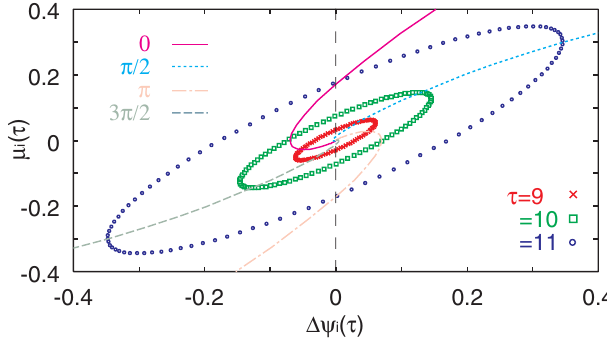
(cid:2) (cid:6) (cid:4) i (cid:2) 0 (cid:4) (solid line), i (cid:2) 0 (cid:4) (cid:3) (cid:1) (dash-dotted line), and i